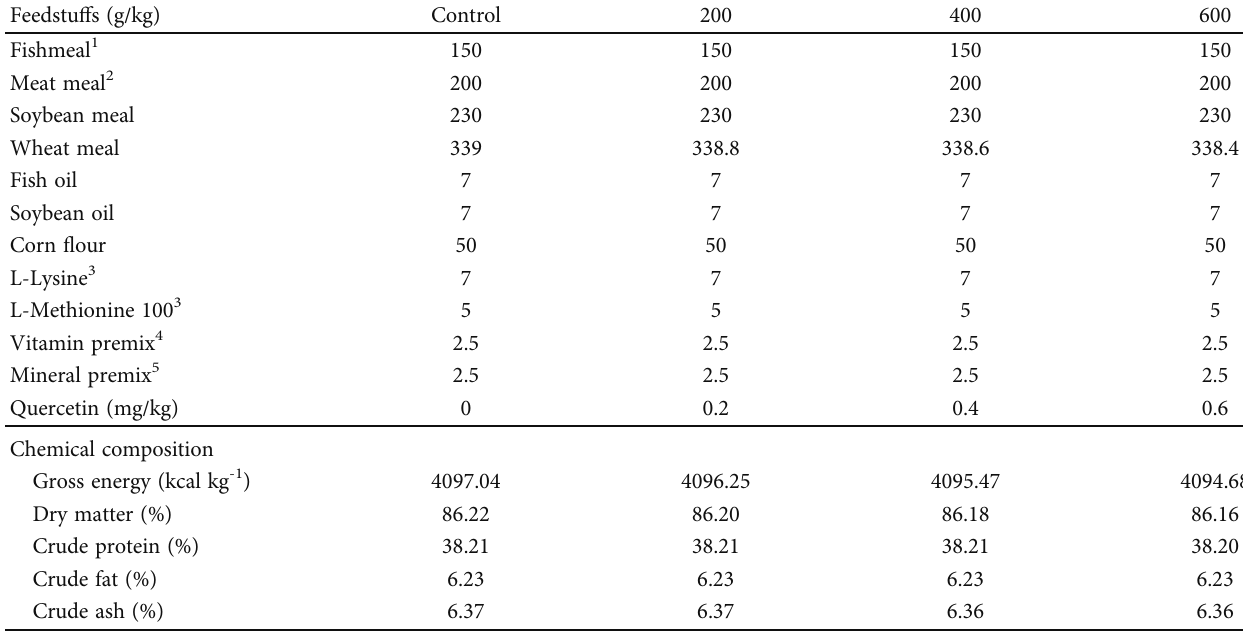
Table 1: Experimental diets and proximate chemical